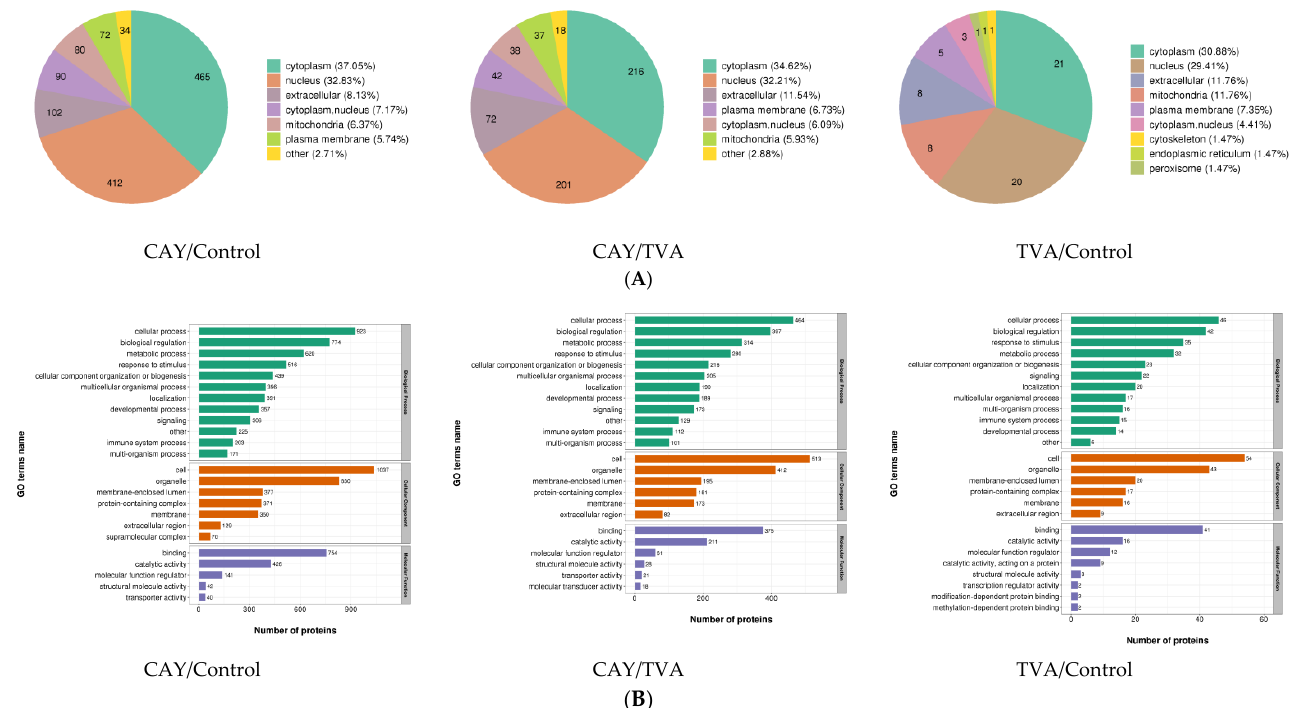
Figure 4. The subcellular structure localization of differentially expressed proteins ( A ) and GO secondary annotation ( B ) in MAC-T cells under different incubation conditions. CAY group (SCD1- inhibited MAC- T cells model): incubated with 50 μM TVA for 2.5 h after the treatment of CAY10566 at concentrations of 10 nM for 12 h, TVA group: only incubated with 50 μM TVA for 2.5 h, and control group: without CAY, TVA.